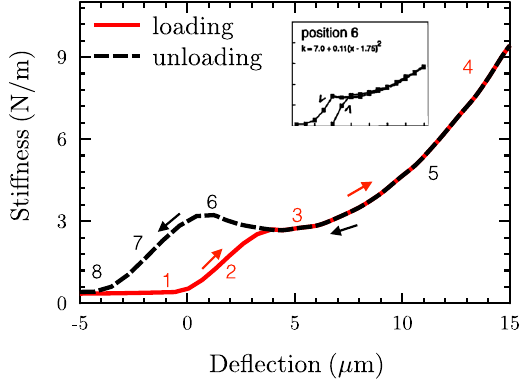
Figure 6. Loading (red line) and unloading (black dashed line) point-stiffness vs. deflection curves of the ABM (using the model in Fig. 1c). The ABM parameters are the same as those of Fig. 3b, but with an increase in the thickness of the arch and upper layer by a factor of 2.2 corresponding to a more basal location of 1.3 mm. The point-stiffness vs. deflection unloading curve was computed by decreasing the TBC layer thickness by 15 μ m to account for the squeezing of the TBC layer by the loading cycle. The inset figure shows point-stiffness vs. deflection measurements for the loading (up-arrow) and unloading (down-arrow) conditions of the PZ at position 6, from ref.